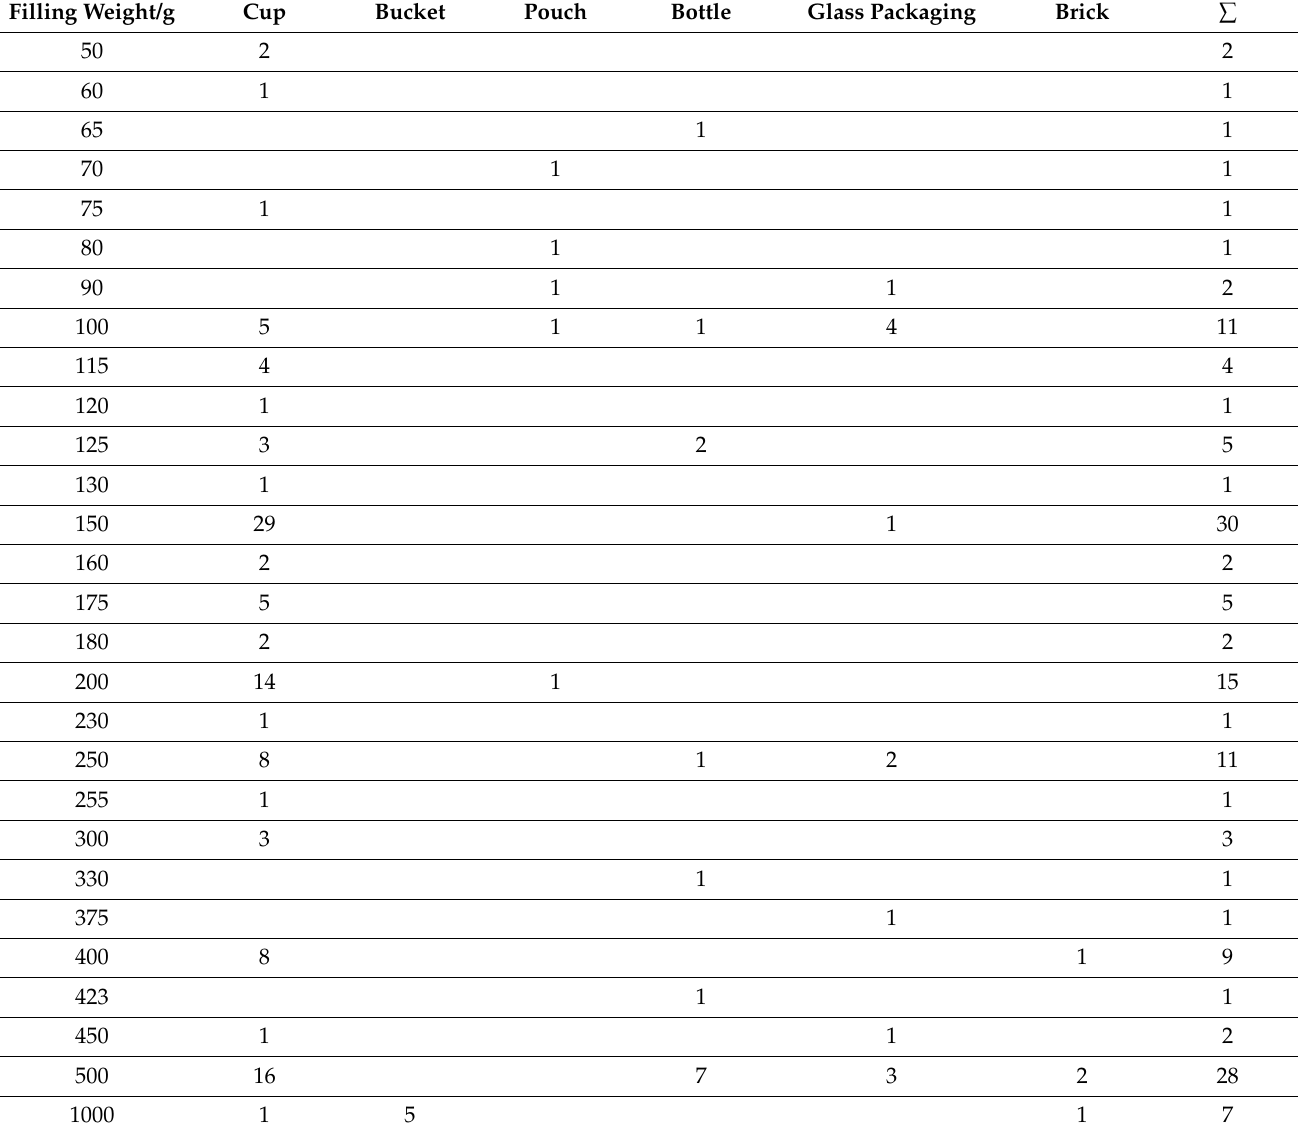
Table 1. Filling weight distribution of different packaging means; number in field: amount of packagings. Filling